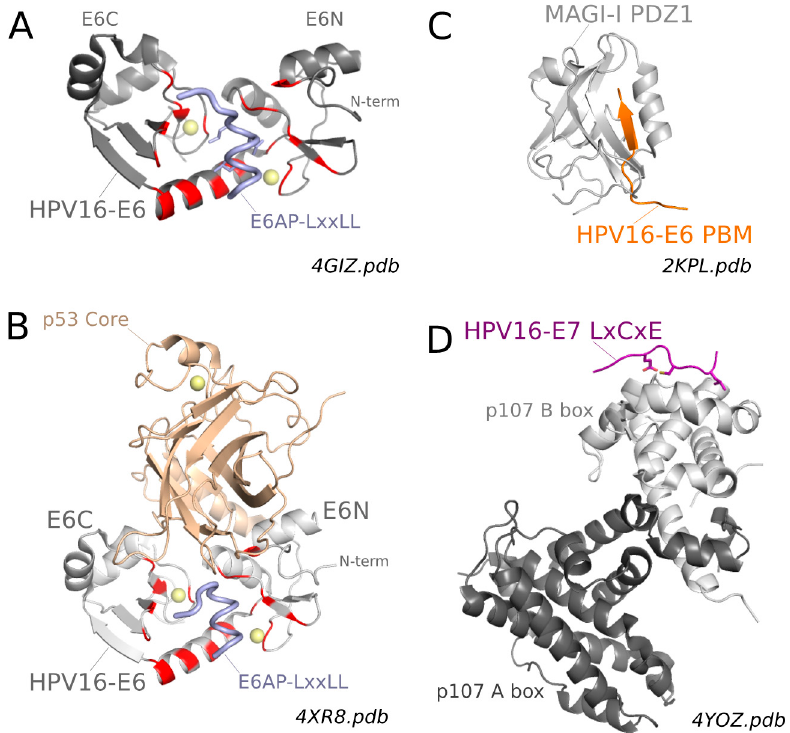
Figure 4. Main structural data on HPV16 E6 and E7 bound to cellular targets. ( A ) Crystal structure of full-length HPV16 E6 bound to the LxxLL motif of E6AP [75] LxxLL binding residues are highlighted in red; ( B ) Crystal structure of HPV16 E6 bound to the LxxLL motif of E6AP and the core domain of p53 [98]; ( C ) Solution structure of MAGI-1 (membrane associated guanylate kinase inverted 1) PDZ 2/6 bound to the C-terminal PDZ-Binding Motif (PBM) of HPV16 E6 [115]. LxxLL binding residues are highlighted in red; ( D ) Crystal structure of p107 pocket domain (composed of A-box and B-box) bound to the LxCxE motif of HPV16 E7 [116]. A comparable crystal structure was previously obtained for pRb pocket domain bound to the LxCxE motif of HPV16 E7 [117].